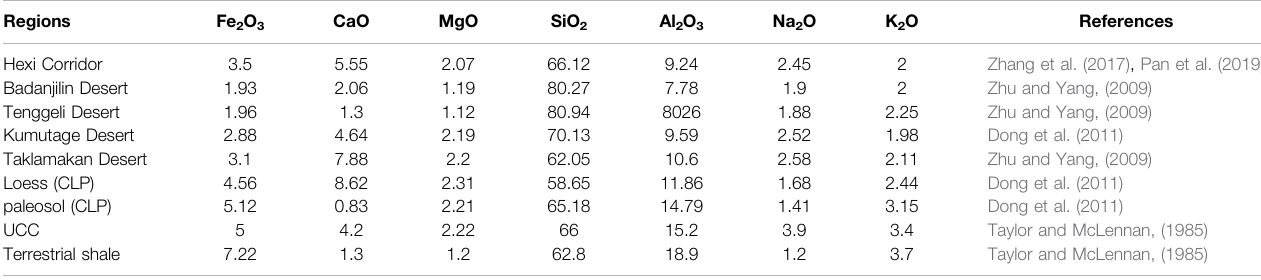
TABLE 4 | The average element contents (%) of sand dunes in the Hexi Corridor and other deserts and the average composition of the upper continental crust (UCC). CLP, the Loess Plateau in China. Regions